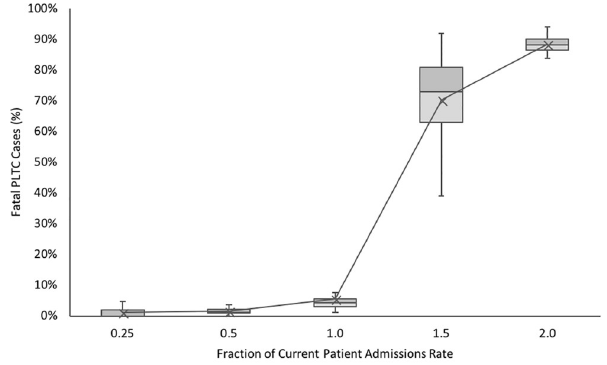
Fig 11. Predicted effect of patient influx rate on mortality rates for patients with